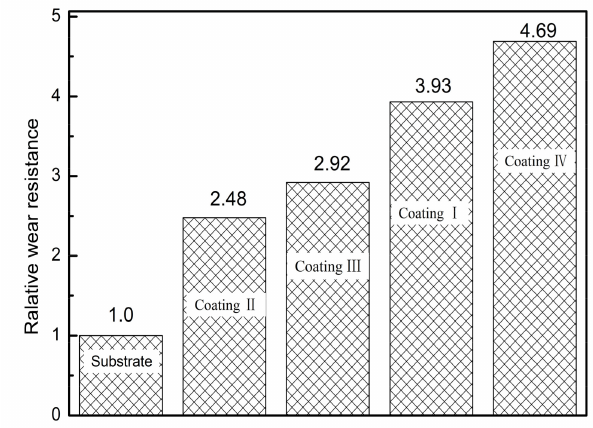
Figure 12. The relative wear resistance of cladding